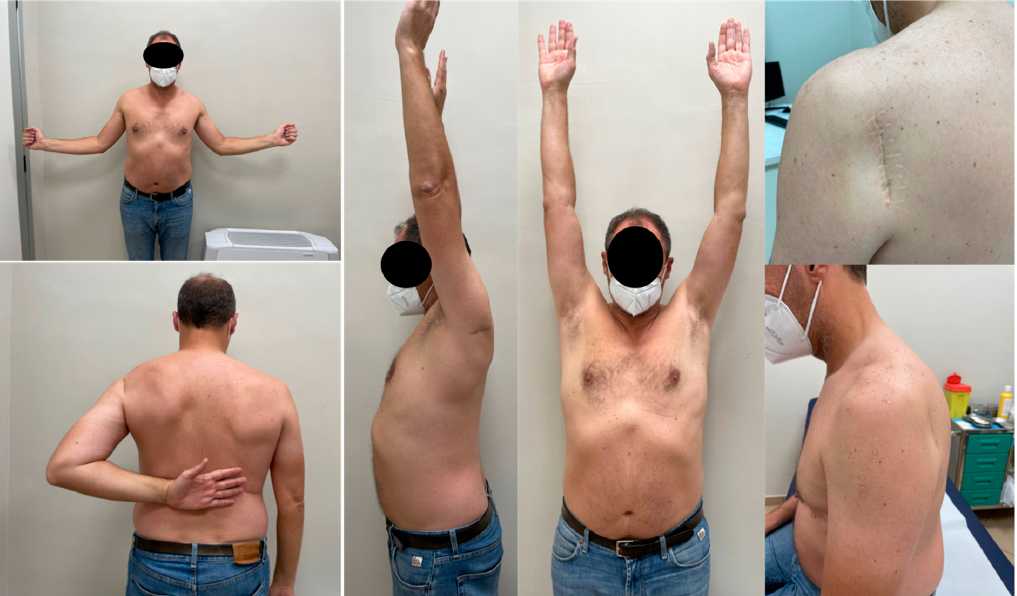
Figure 5. Final follow-up (48 months) and aesthetic results of a 53ys male patient who sustained a left three-part posterior fracture-dislocation of the humeral head with composite tuberosity shield fragment treated with a biomechanically validated con fi guration of blocked threaded wires. Six patients (54.5%) described their pain intensity as 0/10, three (27.3%) as 1/10, and two (18.2%) as 2/10 according to the VAS.